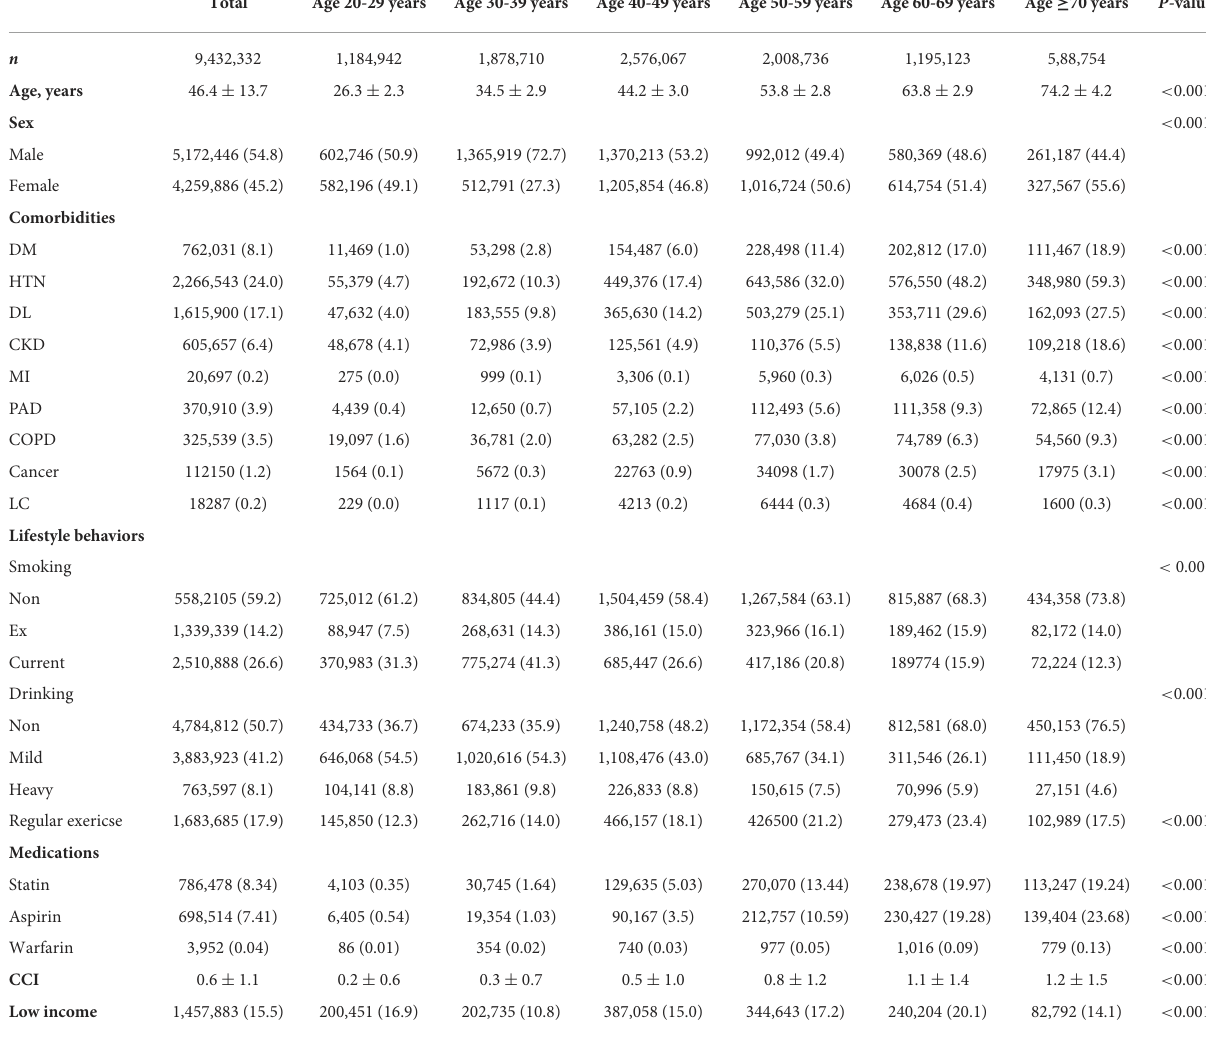
TABLE 1 Baseline characteristics of the study